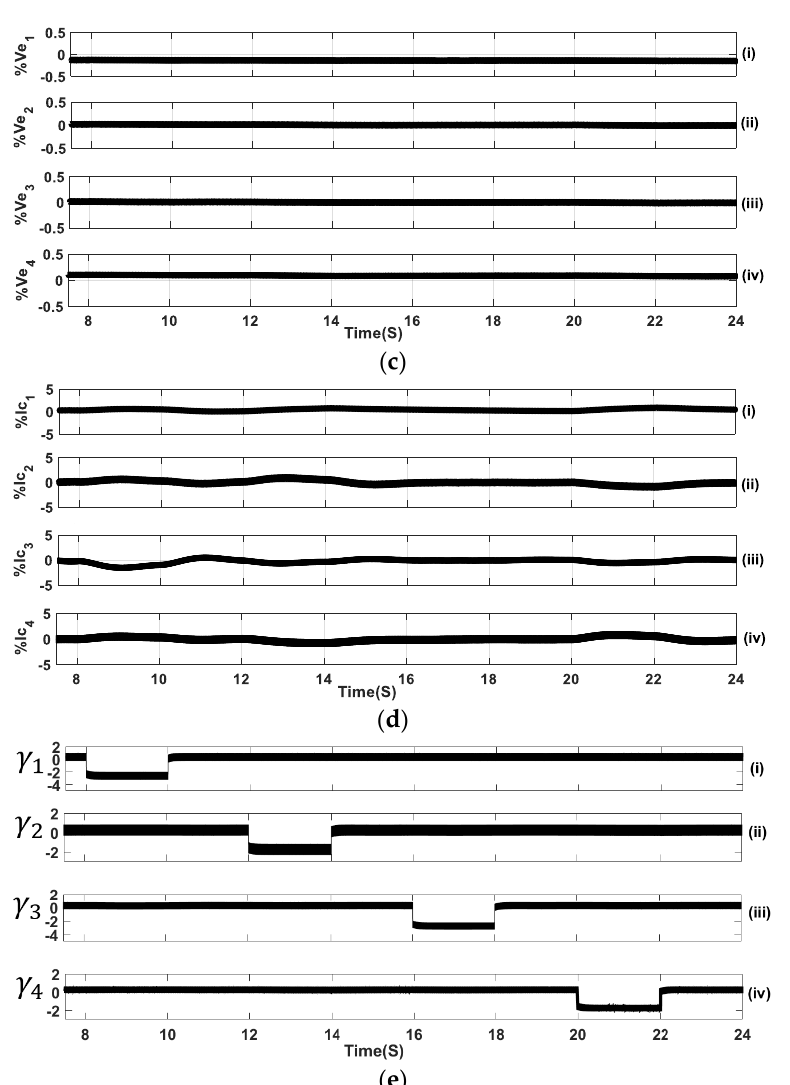
Figure 13. Fourth case study: ( a ) v i , ( b ) I out i , ( c ) % Ve i , ( d ) % Ic i , and ( e ) current cyber-attack mitigation signals for DGUs, γ i